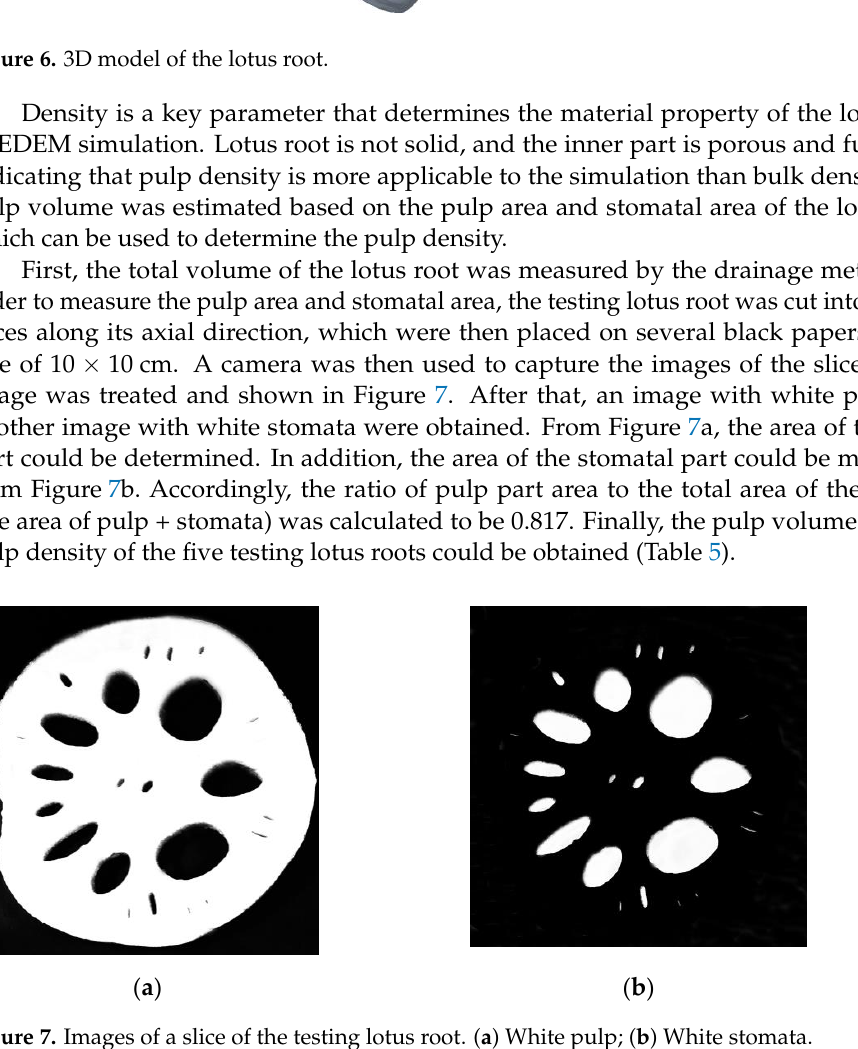
Figure 6. 3D model of the lotus root.